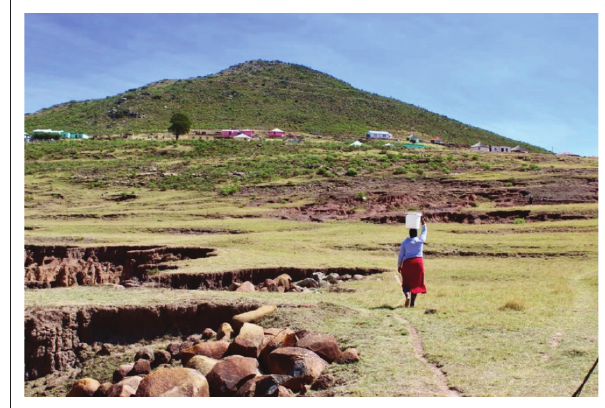
FIGURE 1: Community member fetching water from the river in Raymond Mhlaba Local Municipality of Amathole District